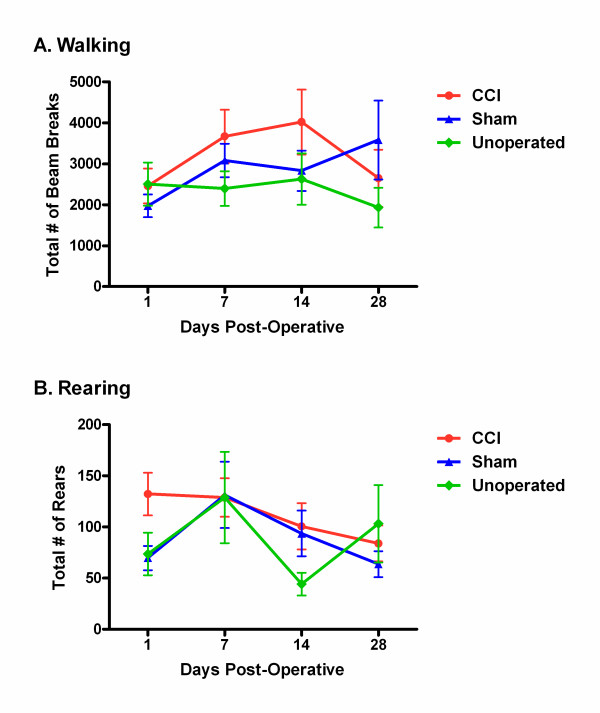
No evidence for reduced locomotor behavior in CCI mice. Symbols represent mean ± S.E.M. (A) walking (total beam breaks minus repetitive breaks of the same beam) and (B) rearing on the hind paws (total breaks of beams located ≈ 10 cm above the floor) in 60 min of mice given CCI surgeries (red), sham surgeries (blue), or unoperated (green), and tested 1, 7, 14 and 28 days post-operatively.